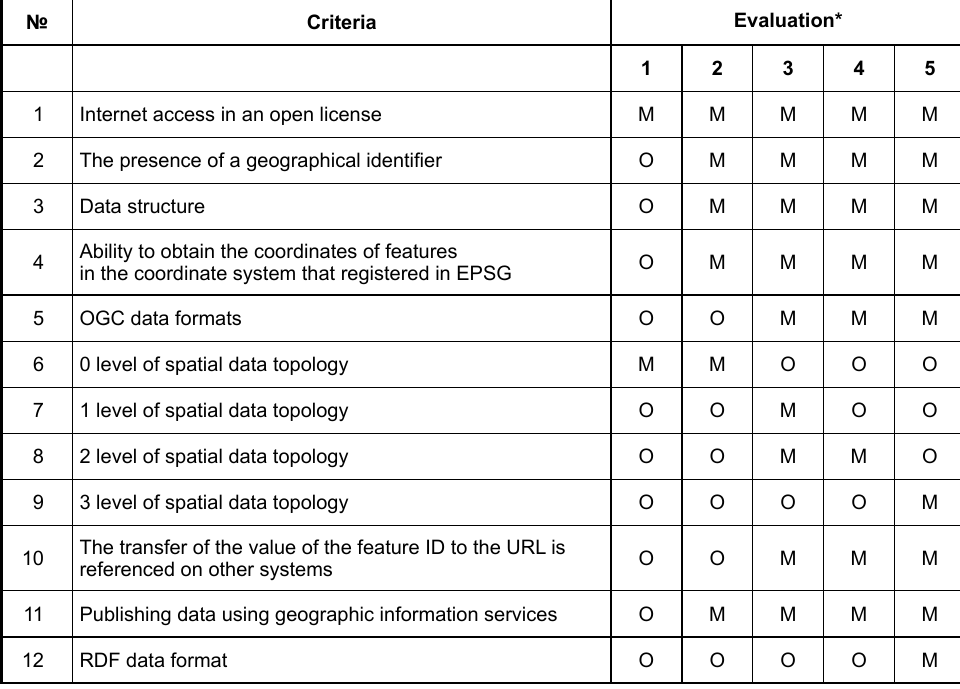
Table 1. The criteria for the quality evaluation of open geospatial data